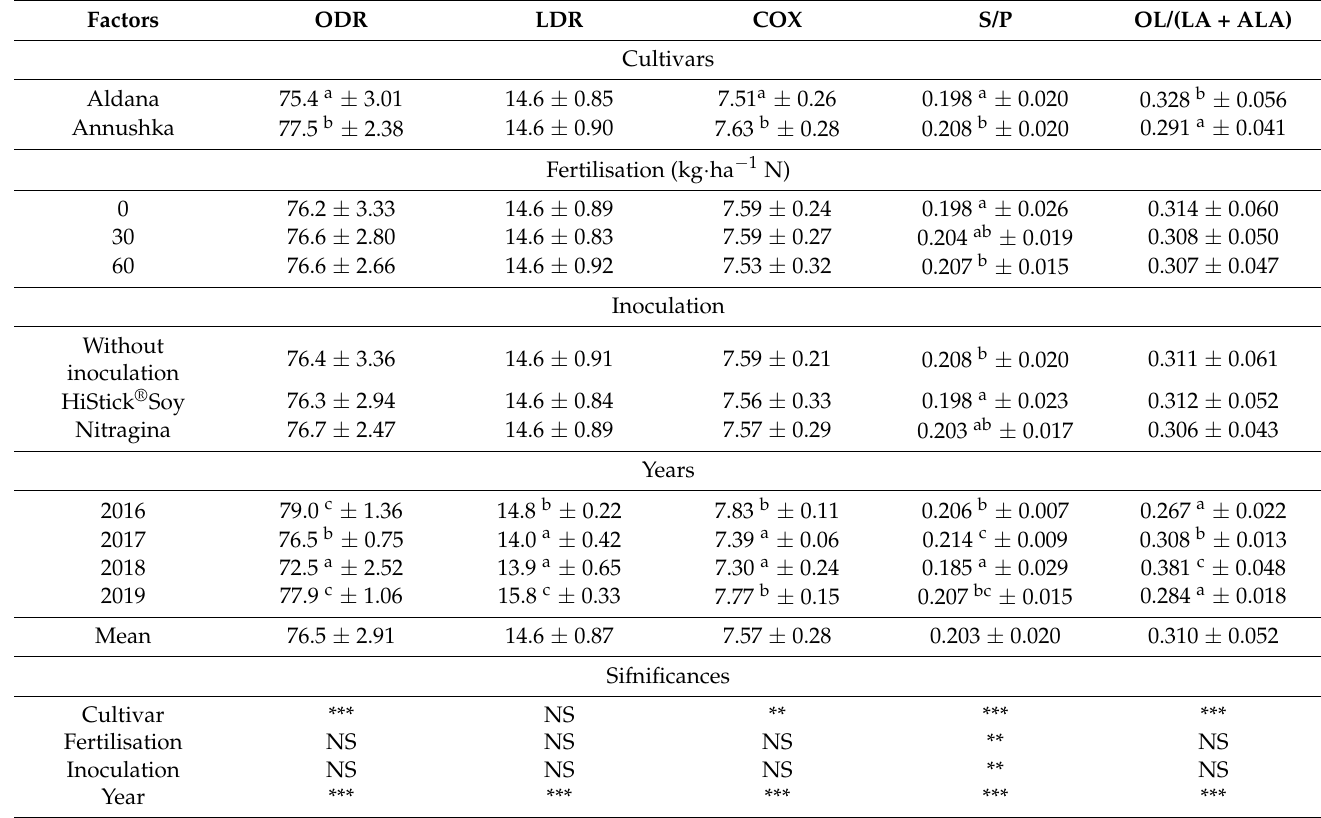
Table 7. The ODR, LDR and COX indices and the S/P, OL/(LA + ALA) ratio of lipid quality in G. max seeds; mean values for